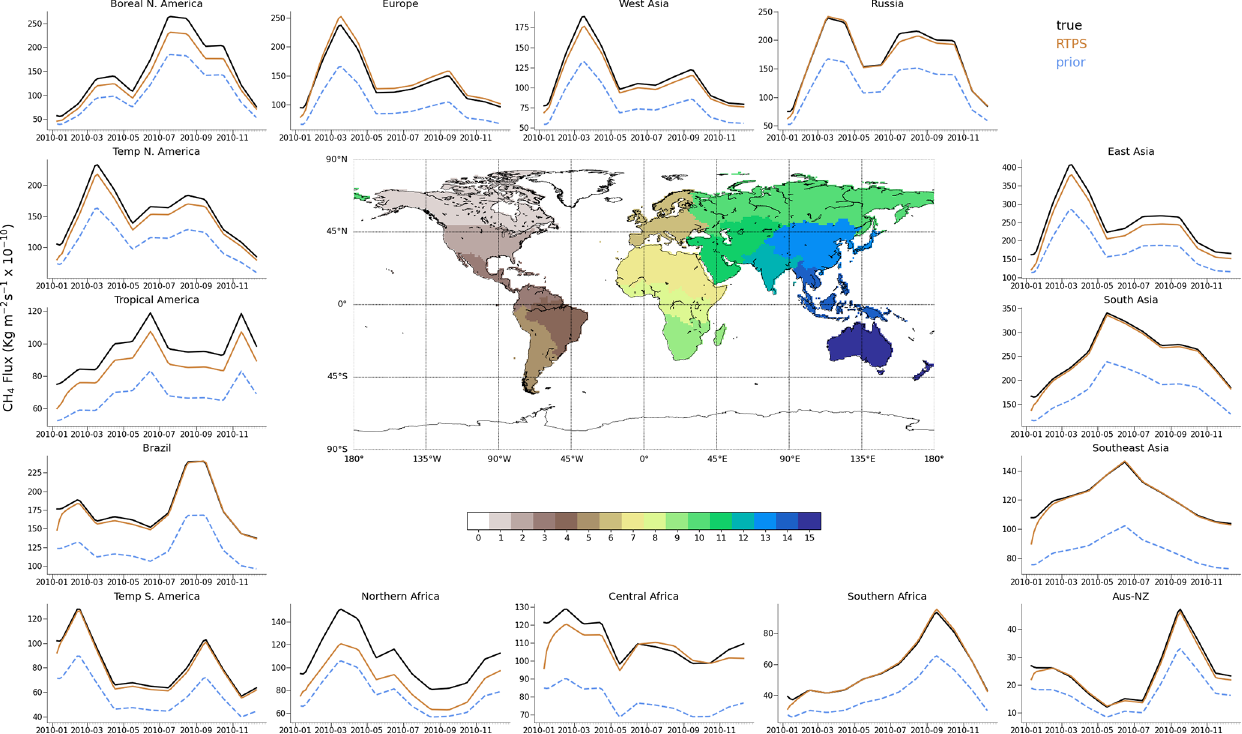
Figure 3. The 1-year CH 4 total flux seasonal cycles of the true flux (black), prior flux (blue), and flux estimated from the LETKF (orange) conditional RTPS inflation method in 15 regions after assimilating dense synthetic surface CH 4